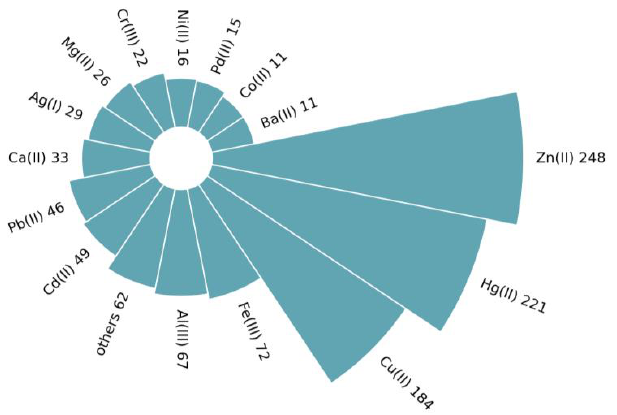
Figure 3. Count of different ions in dataset.